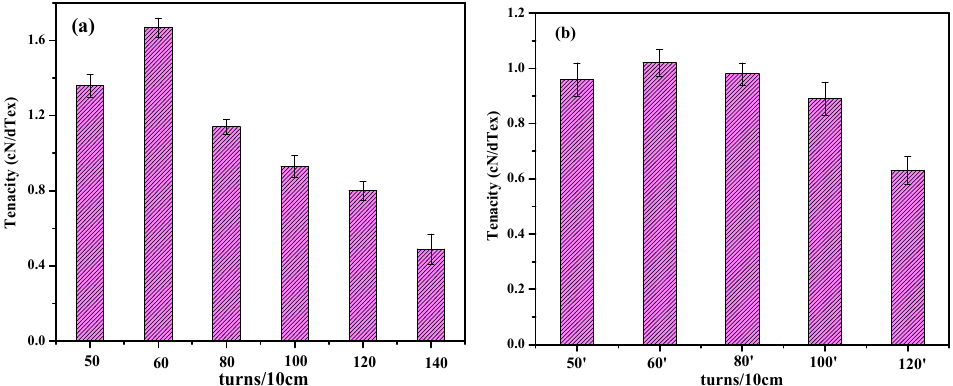
Figure 4. The breaking strength of conductive wrapped yarns as related to the twist counts. ( a ) one metallic wire; ( b ) two metallic wires.